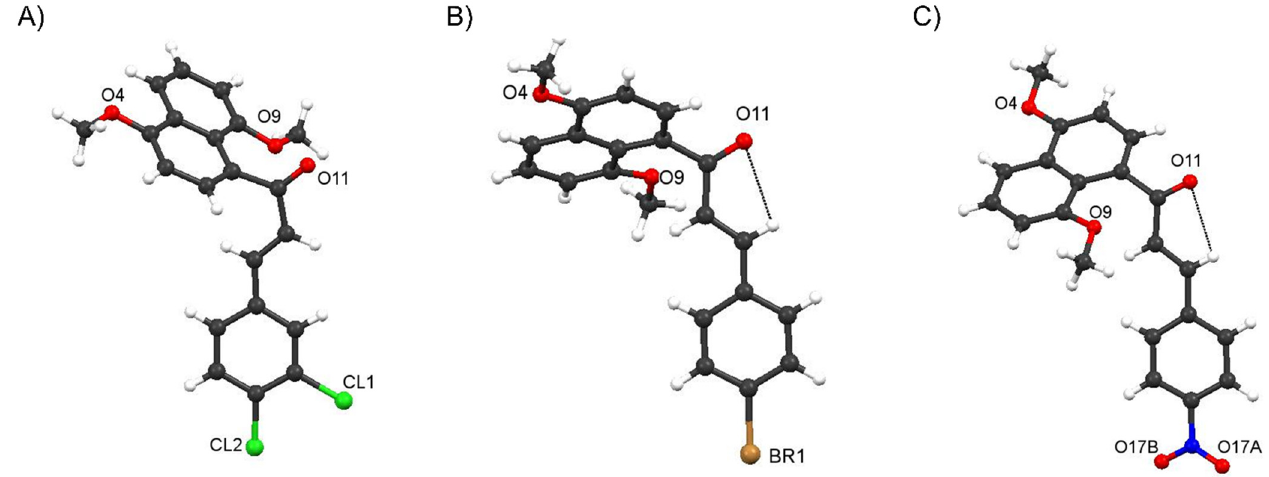
Figure 4. Comparative conformations of solid 4c ( A ), 4i ( B ) , and 4f ( C ) looking perpendicular to the plane of the phenyl ring.